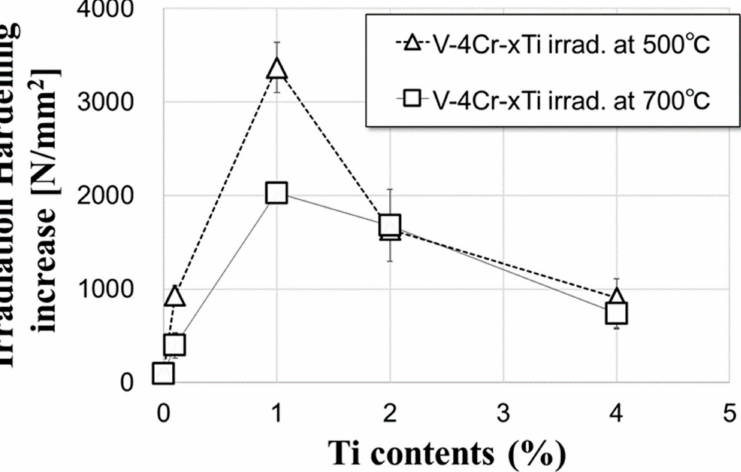
Figure 3. Irradiation hardening increase of V–4Cr–xTi alloys with conventional impurity level irradiated at 500 ◦ C and 700 ◦ C as a function of Ti